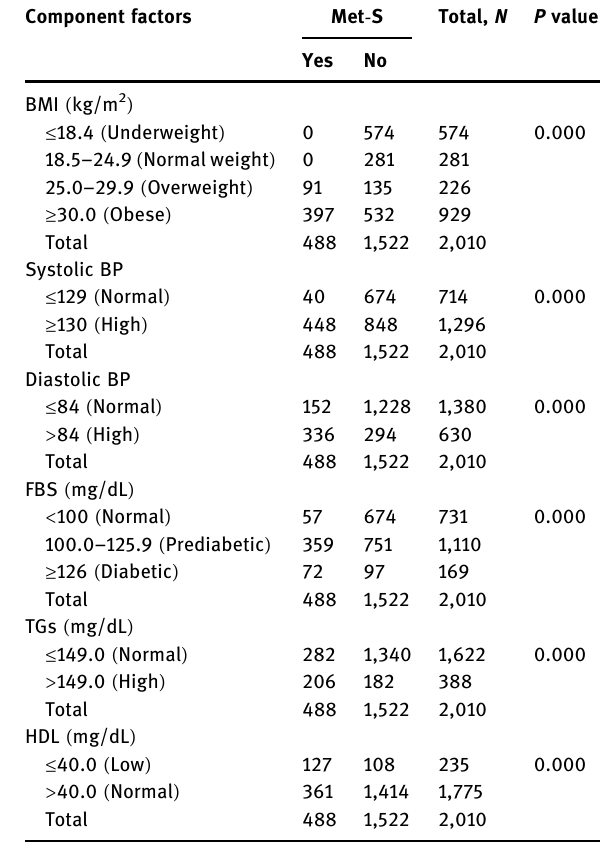
Table 2: Association between Met - S and its individual component factors in subjects using the common cut - o ff